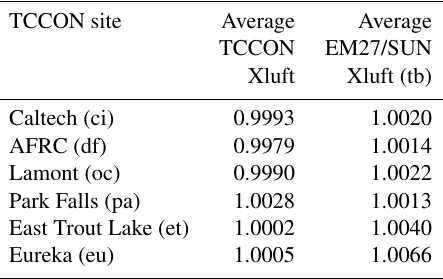
Table 6. Average Xluft values measured by TCCON (125HR) and the reference EM27/SUN